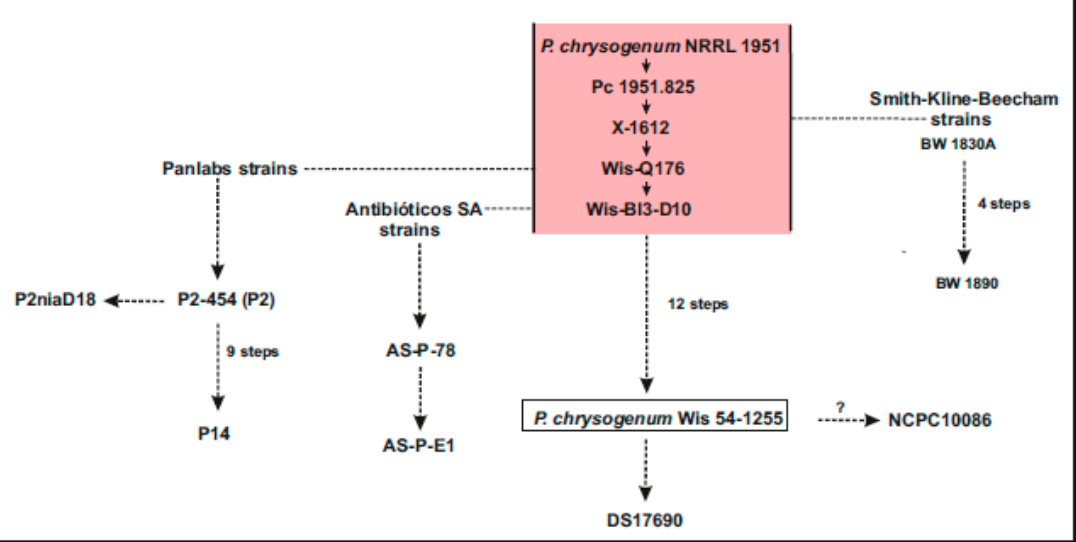
Figure 1. Phylogenetic three of the most relevant industrial strains of P. chrysogenum . This three is constructed based on the information of Lein et al. [19], Newbert et al. [22], Salo et al. [28] and Fierro et al. [24]. The number of mutagenic steps is indicated where it is known. The origin of P. chrysogenum NCPC10086 is discussed in the text. Stage 1 includes steps from the wild type P. chrysogenum NRRL1951 to P. chrysogenum Wis 54-1255. Stage II includes steps from P. chrysogenum Wis54-1255 to P. chrysogenum DS17690 (see text). The early steps of stage 1 from which derive some industrial lineages are highlighted in pink color, although the specific branching step is sometimes unknown. The standard reference strain P. chrysogenum Wis54-1255 is